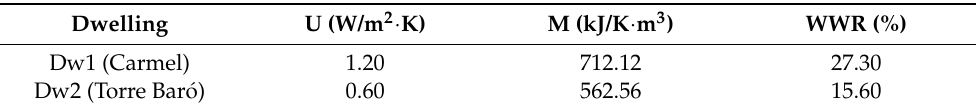
Table 1. Dwelling’s buildings characteristics. Own elaboration based on data from